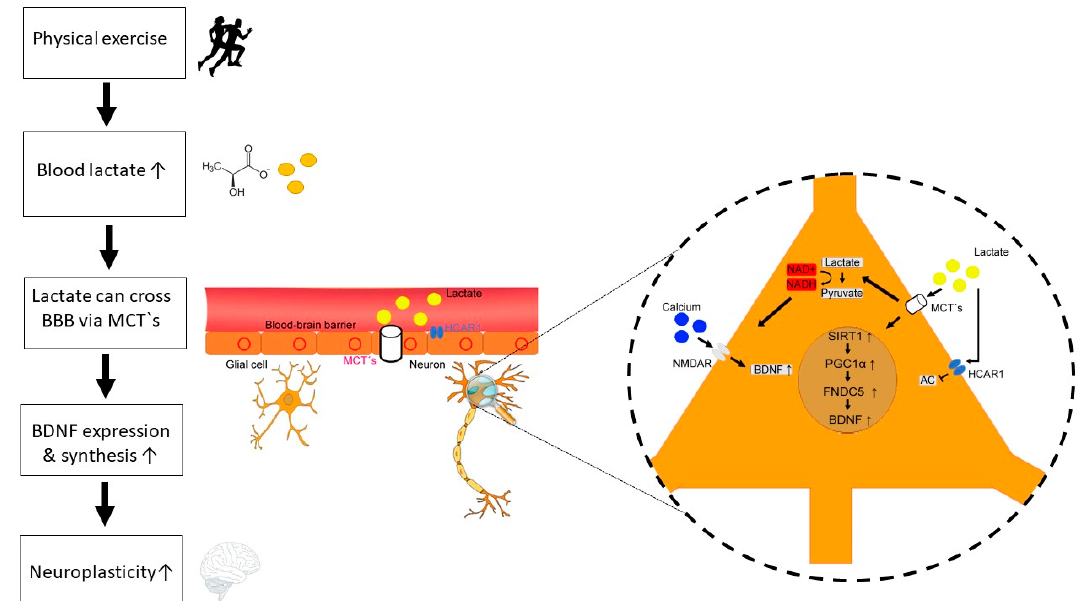
Figure 1. Potential mechanisms of lactate-BDNF interaction following physical exercise. Physical exercise is associated with intensity-dependent increase of lactate levels. Lactate can cross the blood-brain barrier (BBB) via di ff erent monocarboxylate transporters (MCT‘s). Furthermore, lactate binding to the hydroxycarboxylic acid receptor (HCAR1) at the BBB can induce angiogenesis. In neurons, lactate exerts several neurotrophic and metabolic e ff ects through transmembrane transport via MCT’s and direct binding to HCAR1. Firstly, lactate binding to HCAR1 on neurons inhibits the adenylate cyclase (AC) and thus decreases cAMP, resulting reduced BDNF expression and regulatory function in the control of blood flow, and synaptic functions. Secondly, lactate can induce the PGC1 α / FNDC5 / BDNF pathway through SIRT1 activation. Thirdly, lactate increases intracellular NADH, resulting in enhanced calcium levels and BDNF gene expression. Released BDNF can then enhance neuroplasticity via di ff erent neurobiological mechanisms (e.g., neurogenesis, synaptogenesis, growth of dendritic spines, long-term potentiation